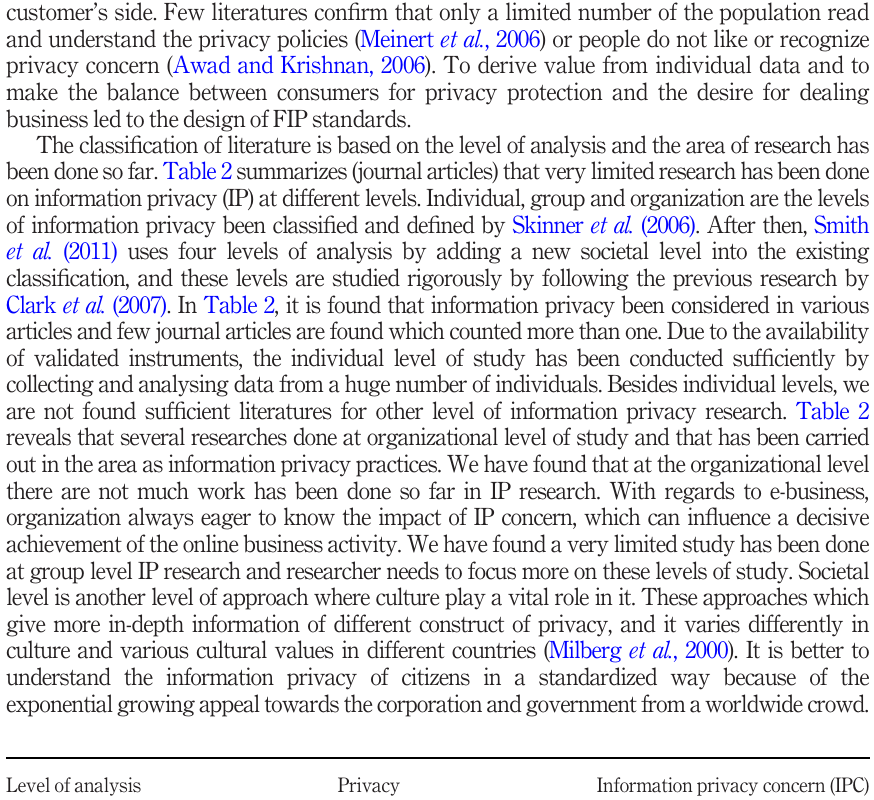
Table 2. Classi fi cation of literature on level of